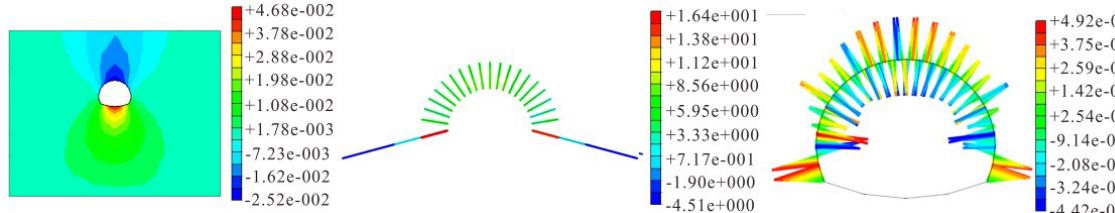
Figure 6. Working Condition 7: vertical displacement of the surrounding rock (mm), moment of shotcrete (KNm), and axial force of the bolt and cantilever beam